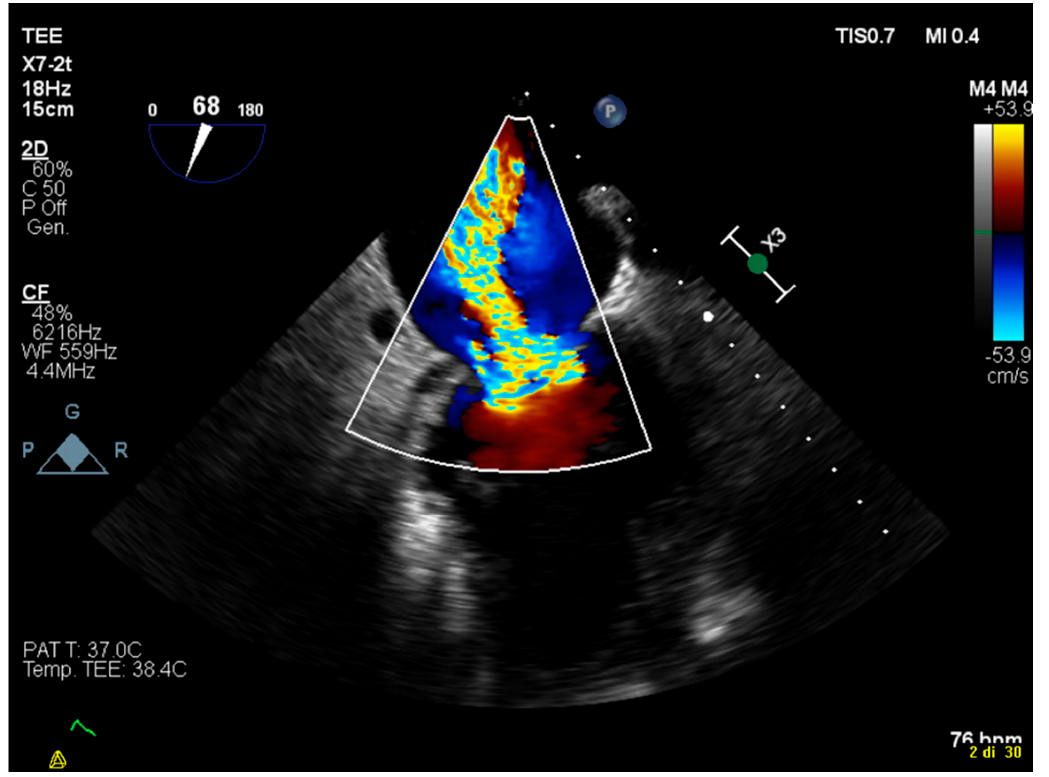
Figure 3. An intercommissural view on the transesophageal echocardiogram highlights severe mitral insufficiency with prevalent mitral regurgitation jet from the A2-P2 mitral valve scallops.